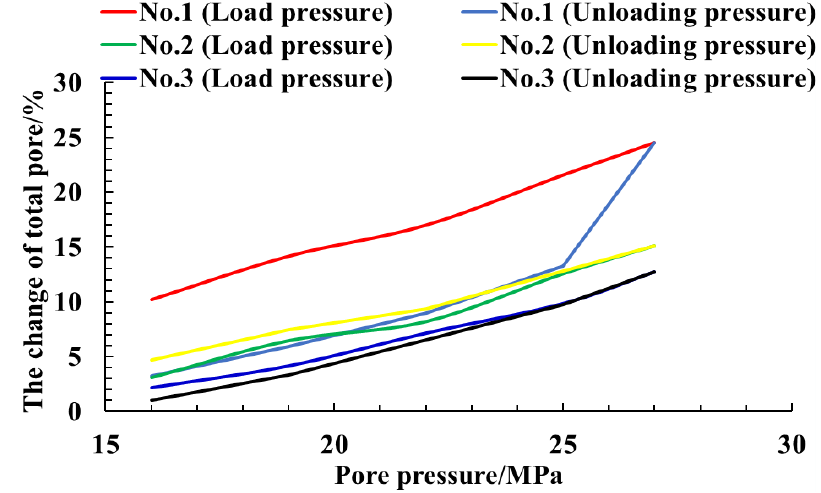
Figure 5. The change rate of total pore under different pore pressures of matrix samples.